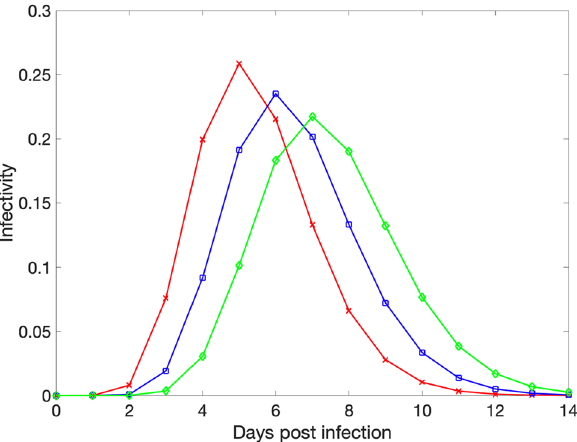
Figure 1. The timing of peak infectivity for each individual varies randomly, peaking at 5 (red curve), 6 (blue curve), or 7 (green curve) days post infection according to a gamma distribution. We do not distinguish between symptomatic and asymptomatic